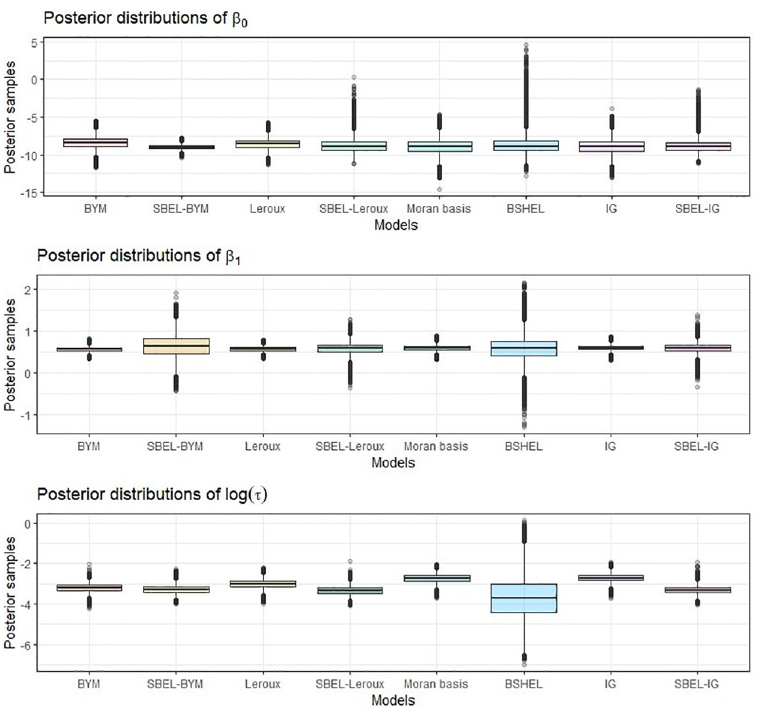
Fig 9. Boxplots of posterior distributions of regression coefficients (parametric vs semi-parametric) for COVID- 19 data for Europe, period 1 (January-April), 2020.